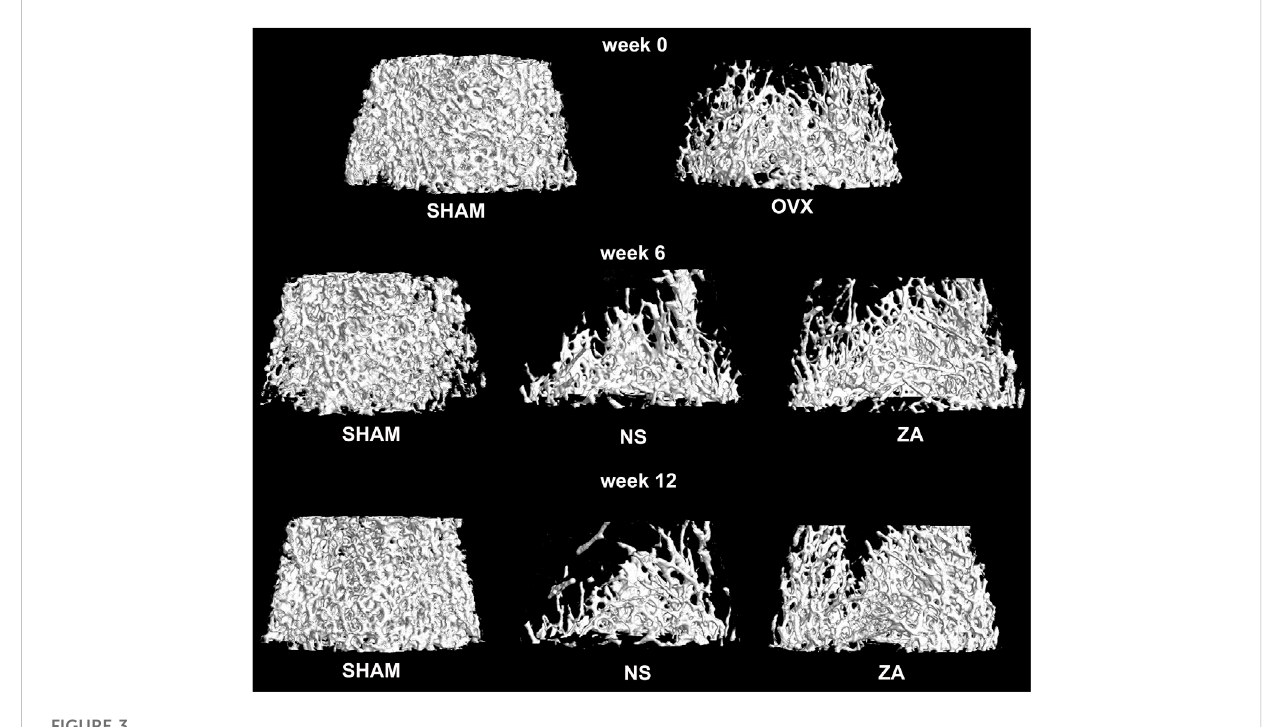
FIGURE 3 Three-dimensional reconstruction of the second lumbar